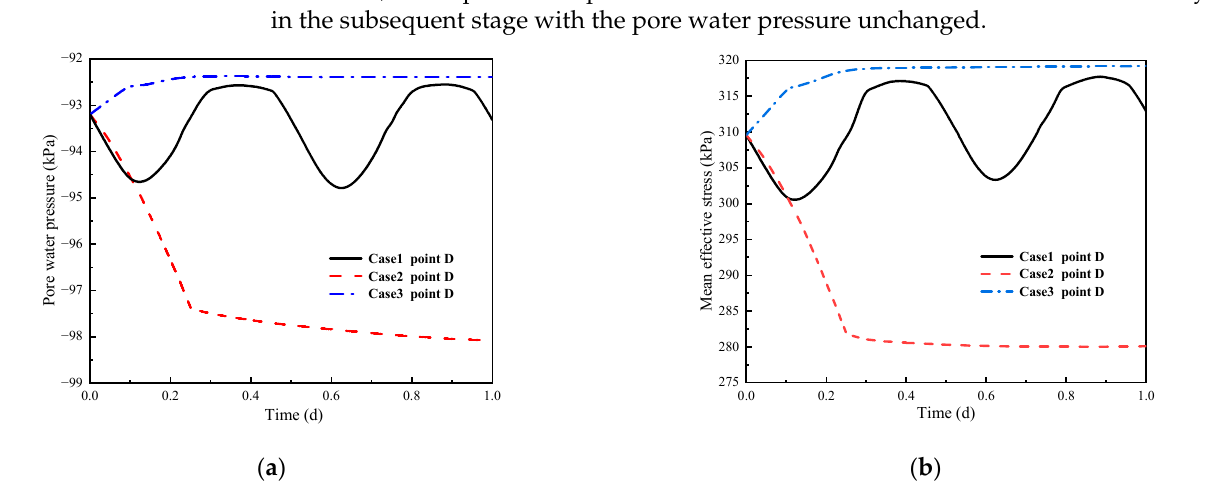
Figure 13. Contours of pore water pressure in the initial state and at the end of moment of the three cases.